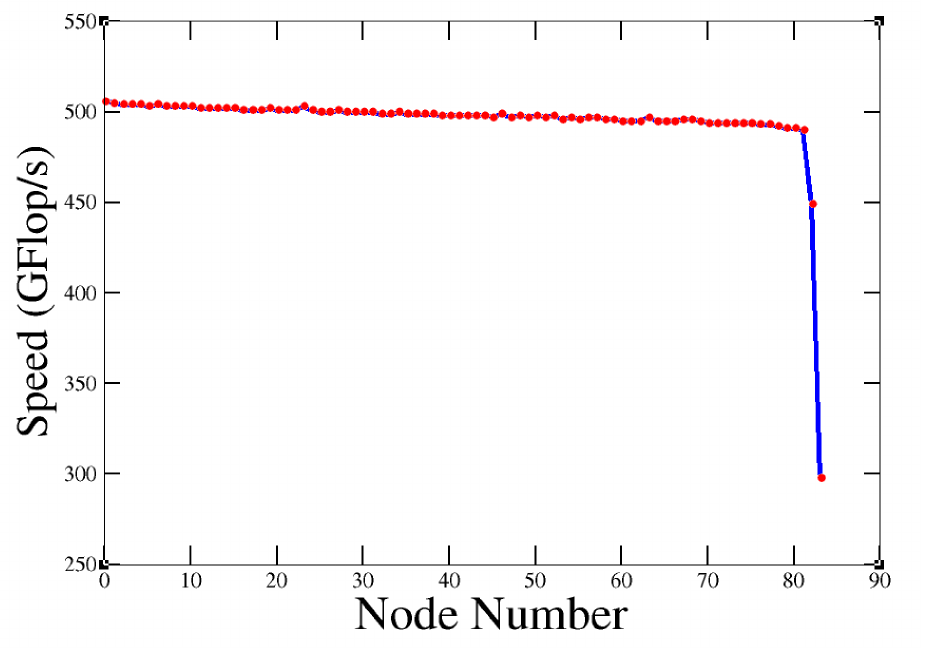
Figure 14. Speed from each node of “Quinde